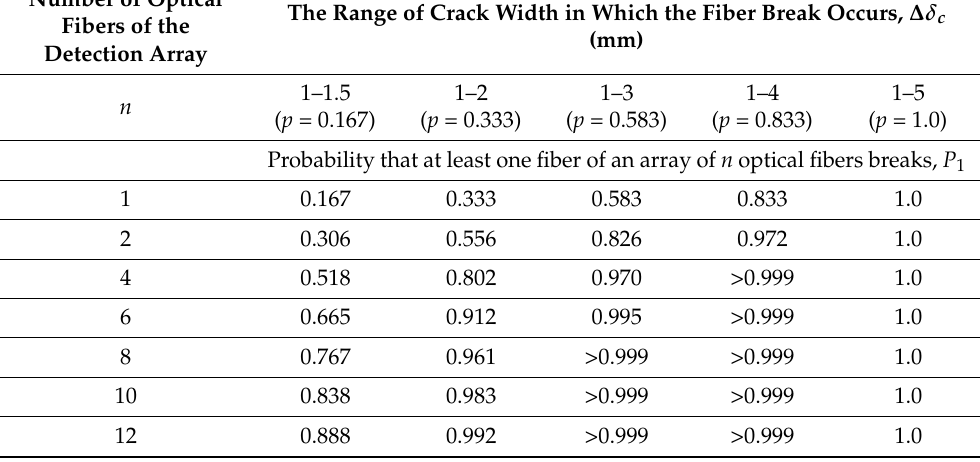
Table 1. Probability that at least one fiber of an array of n optical fibers breaks, P 1 , calculated for several ranges of crack widths ∆ δ c and detection arrays of 1, 2, 4, 6, 8, 10, and 12 optical fibers. Number of Optical The Range of Crack Width in Which the Fiber Break Occurs, ∆ δ c Fibers of the (mm) Detection Array 1–1.5 1–2 1–3 1–4 1–5 n ( p = 0.167) ( p = 0.333) ( p = 0.583) ( p = 0.833) ( p = 1.0) Probability that at least one fiber of an array of n optical fibers breaks, P 1 1